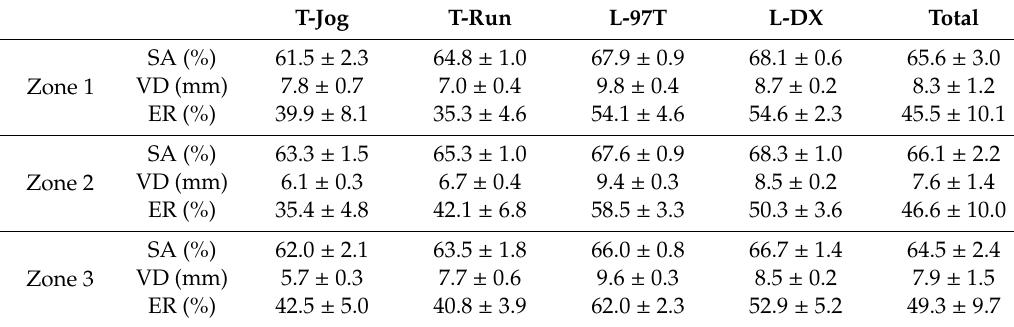
Table 1. Descriptive statistics of the sample (mean ± SD).